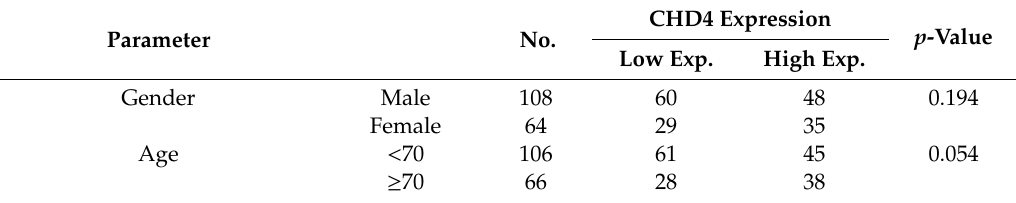
Table 1. Associations and comparisons between CHD4 expression and clinicopathological factors in 172 rectal cancer patients who were receiving neoadjuvant CCRT. High expression of CHD4 was significantly associated with pre-Tx tumor status ( p < 0.001), pre-Tx lymph node metastasis ( p < 0.001), post-Tx tumor status ( p < 0.001), post-Tx lymph node metastasis ( p < 0.001), vascular invasion ( p = 0.042), and tumor regression grade ( p =